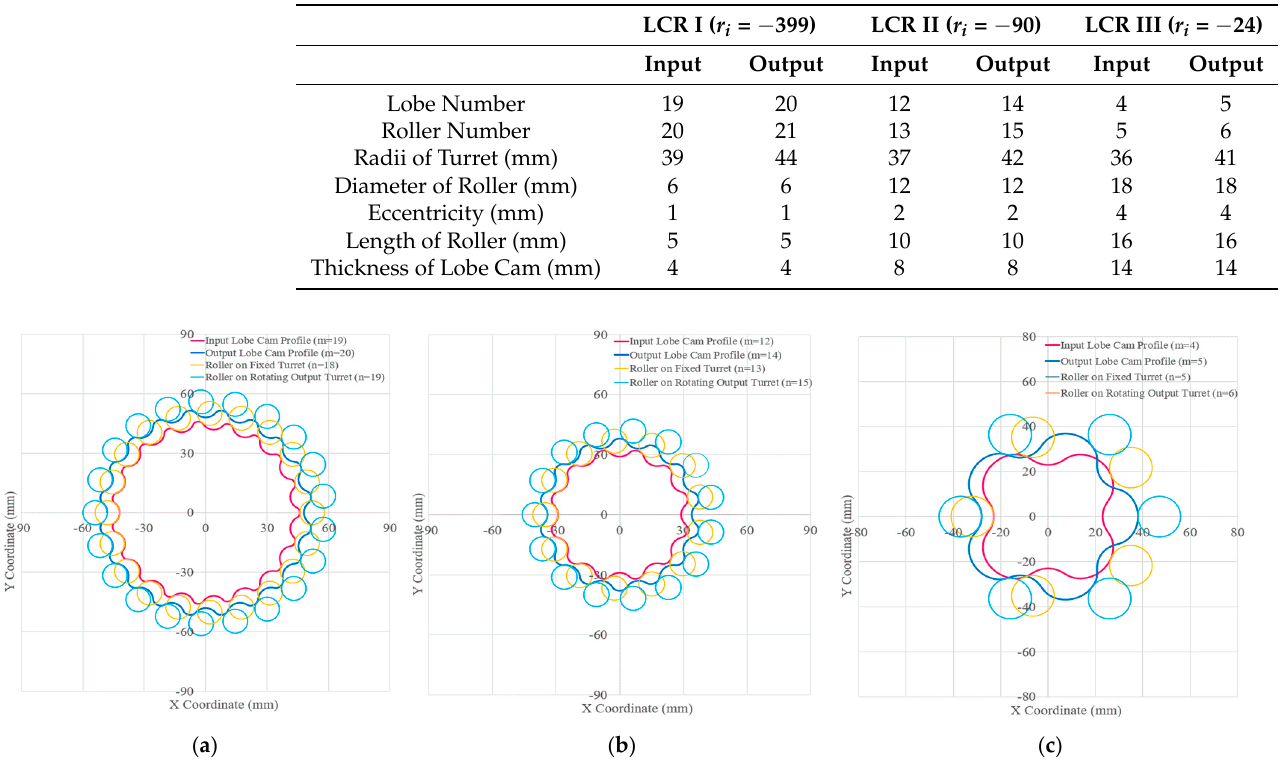
Table 2. Design parameters of three lobe cam reducers.